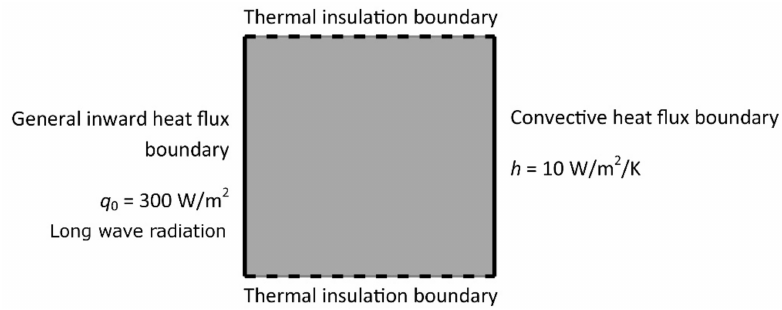
Figure 7. Thermal boundary conditions on the modeled PCM